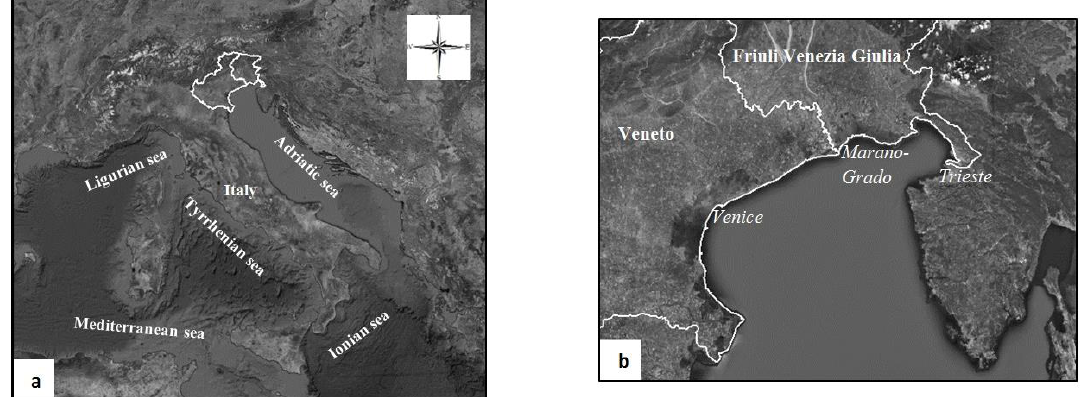
Figure 1. ( a ) Location of the study area in the North Eastern Italy; ( b ) the coast of Veneto and Friuli